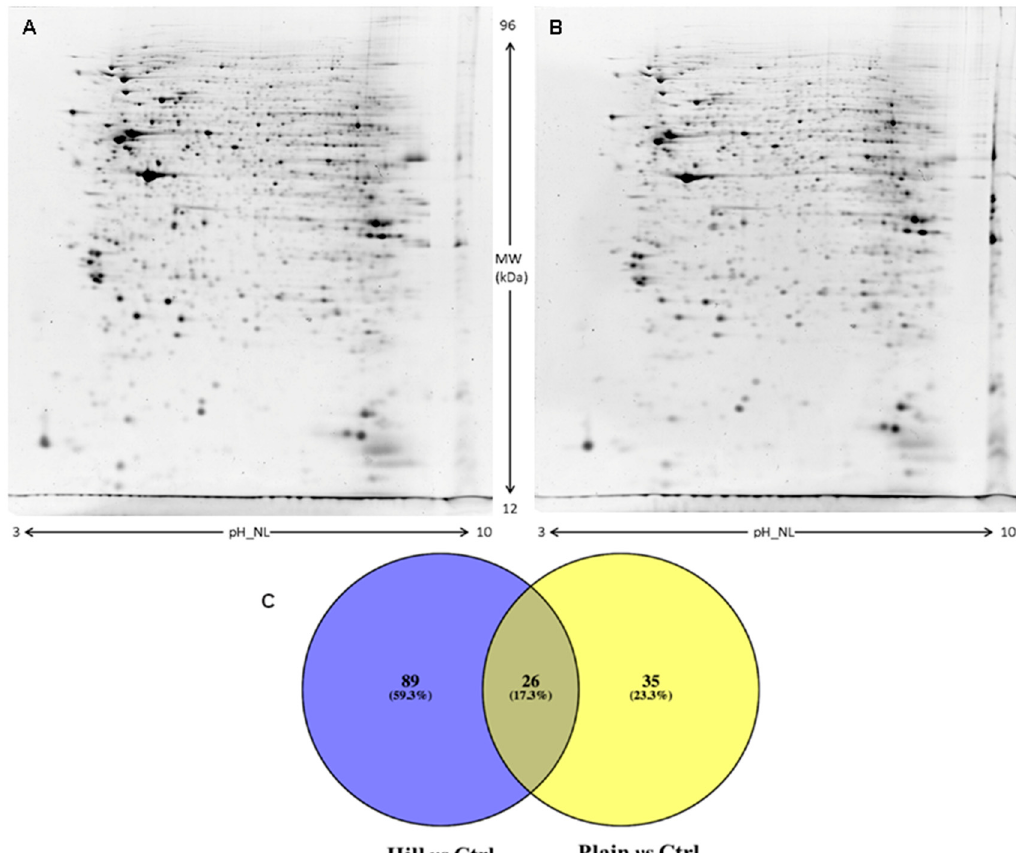
Figure 6. 2DE representative images of differentiated SH-SY5Y cell proteins treated with Hill ( A ) and Plain ( B ) extracts. Venn diagram ( C ) of different comparisons. ( A , B ) SH-SY5Y proteins were separated in a 3–10 nonlinear gradient. SDS-PAGE was performed using 12% acrylamide. Gels were stained with ruthenium. ( C ) Venn diagram highlighting the distribution of identified differentially expressed proteins in hill and plain extracts as compared to control. Both unique and overlapping proteins are reported as actual number and percentage (Venny 2.0.2).